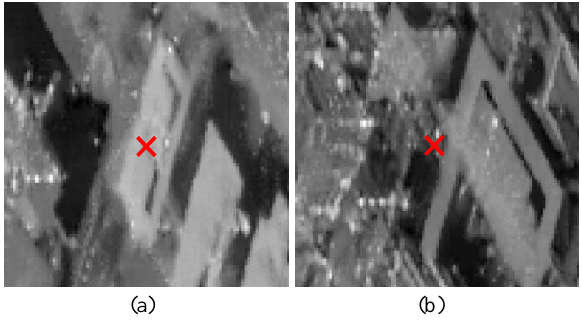
Figure 7. The test areas also extracted from a TerraSAR-X high resolution spotlight mode image. (a) The LMU subset. (b) The TUM subset. The red crosses in the patch center should correspond to the red crosses in the optical images shown in Figs. 2 and 6,